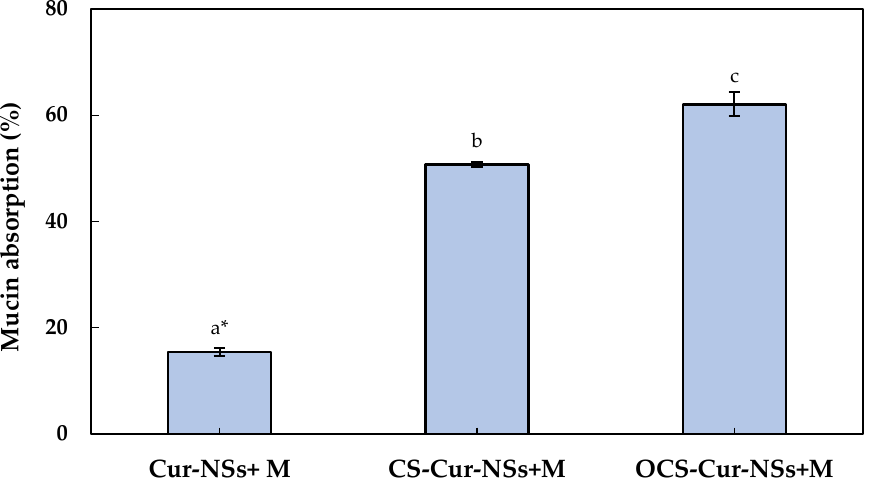
Figure 3. Mucin absorption of Cur-NSs, CS-Cur-NSs, and OCS-Cur-NSs after interaction with mucin protein. * Different letters indicate a significant difference at p < 0.05. Error bars indicate the standard deviation.